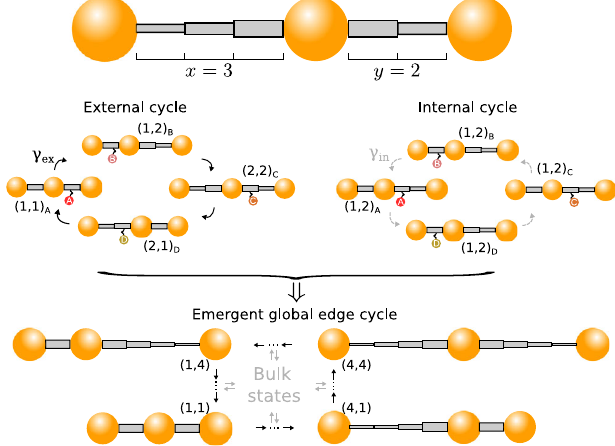
FIG. 7. Topologically protected three-sphere swimmer, imple- mented within our four-state model. In this case, the coordinates x and y describe the extension of the left and right arms, respectively. The internal states A, B, C, and D represent whether the left or right arm is primed for increasing or decreasing its length. The emergent topologically protected edge current results in cyclic shape deformations that enclose the maximally available area in shape space (in this example, we set the minimal and maximal extension of the arms to be 1 and 4,